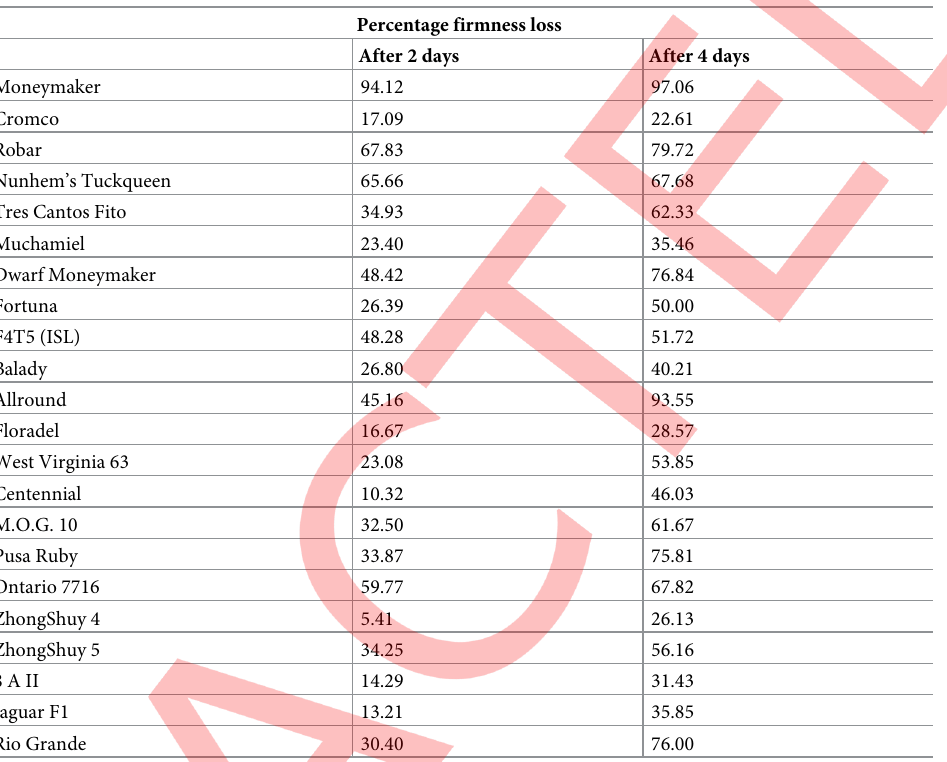
Table 3. Percentage firmness loss after 2 days and 4 th day of